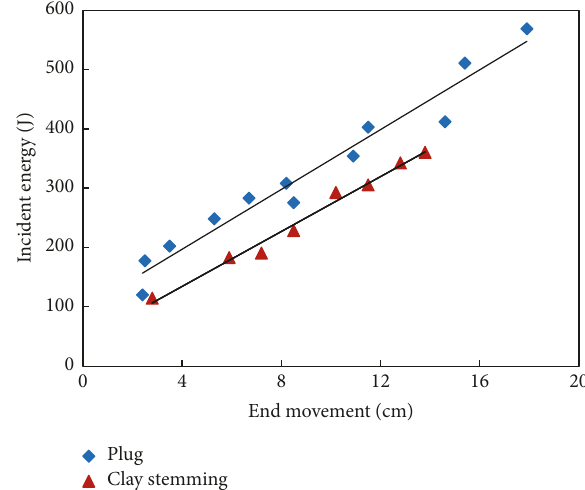
Figure 7: Relationship between the impact incident energy and end